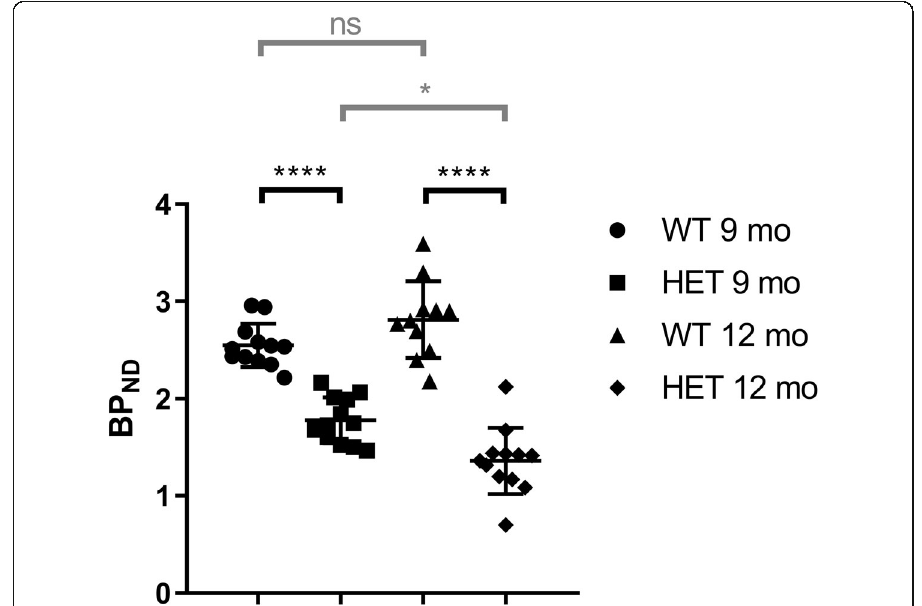
Fig. 3 Individual and mean ± SD binding potential of [ 18 F] fallypride in WT and HET zQ175DN KI mice. Statistical analysis using paired two-tailed T-test (gray line) and unpaired two-tailed T-test (black line, ns = nonsignificant, *** p = 0.005, **** p <